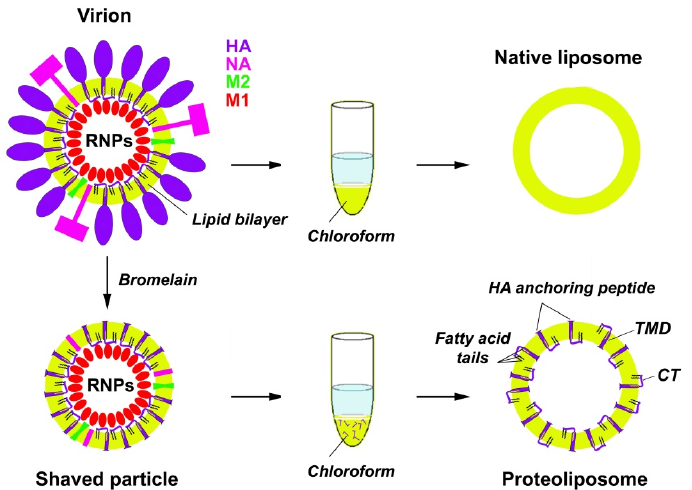
Figure 1. A scheme demonstrating protocols for preparation of native liposomes and proteolipo- somes from purified PR8 virions and subviral particles, respectively. Influenza A virus structural proteins are designated as HA – hemagglutinin, NA – neuraminidase, M2, M1. The virus nucleocapsid composed of eight single-stranded negative-sense RNA molecules complexed with nucleoprotein and RNA polymerase proteins is designated as RNPs (ribonucleoprotein particles) for simplic- ity. Within the proteoliposomes, the HA LI45 peptides are designated as violet patterns. They pos- sess the transmembrane domain (TMD), cytoplasmic tail (CT) regions, and S-acylation modification (three fatty acid tails bound via thioester bonds) anchoring the CT region to the lipid bilayer as indicated.